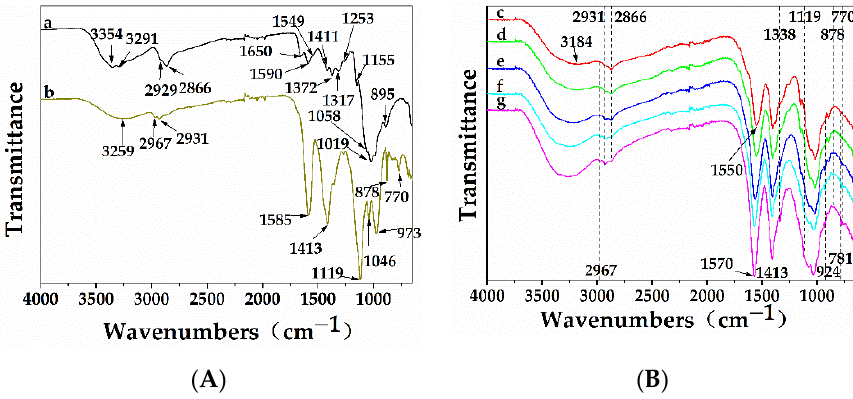
Figure 2. ( A ) FTIR spectra of (a) chitosan and (b) sodium lignosulfonate; ( B ) FTIR spectra of sodium lignosulfonate/chitosan adhesives (L/C) with different mass ratios of sodium lignosulfonate to chitosan: (c) 1:3, (d) 1:2, (e) 1:1, (f) 2:1, and (g) 3:1.